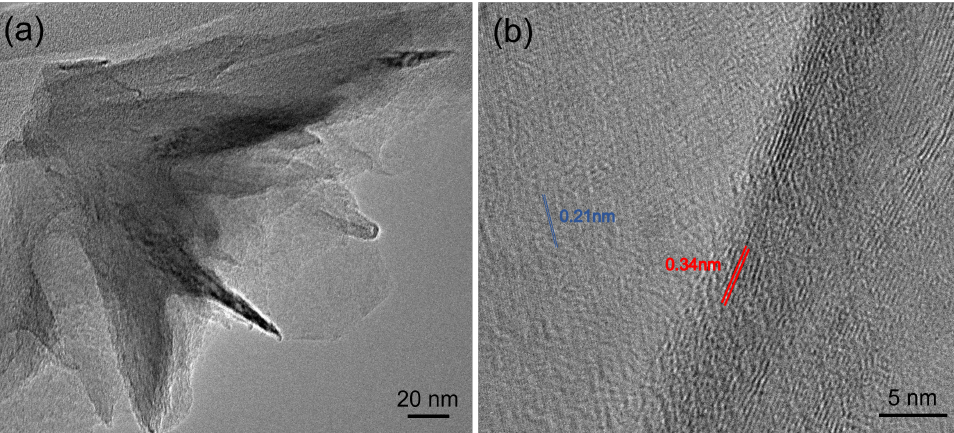
Figure 5. ( a ) Low-resolution TEM image and ( b ) high-resolution TEM image coming from the same sample of Figure